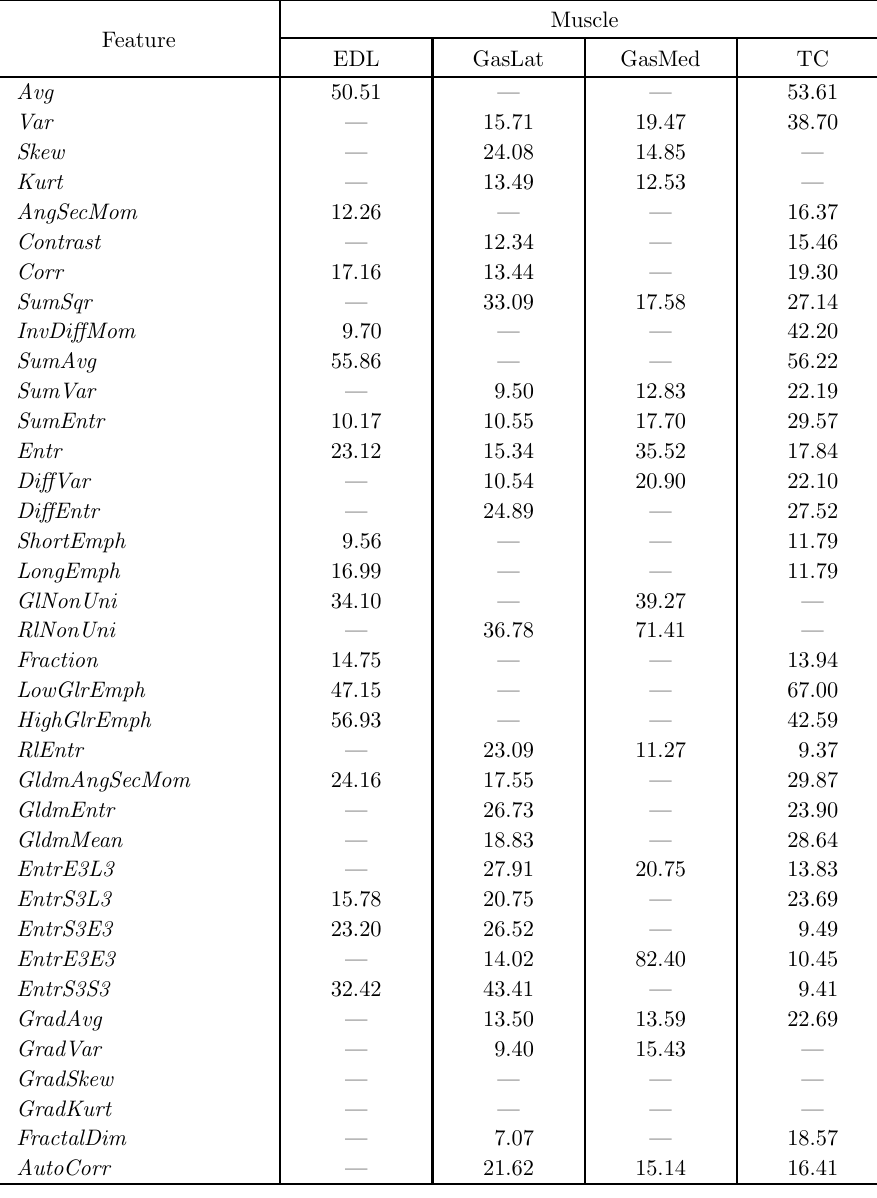
Table 6. The second (ii) differentiation problem: the second phase vs. the third phase. Features marked by an em dash (“—”) demonstrated statistically significant differences between the considered phases of growth in healthy dogs ( α = 0.05). The remaining features were used in the identification of dystrophy phases in GRMD dogs. The corresponding numbers are incidences of selections [%] in the modified MC procedure Muscle Feature EDL